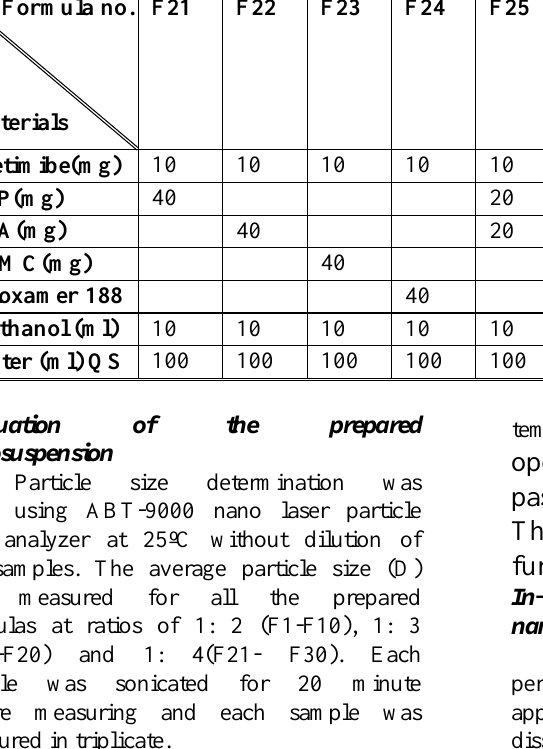
Table (3): Composition of ezetimibe nanosuspension using different types of stabilizers at drug: stabilizer ratio 1:4 Formula